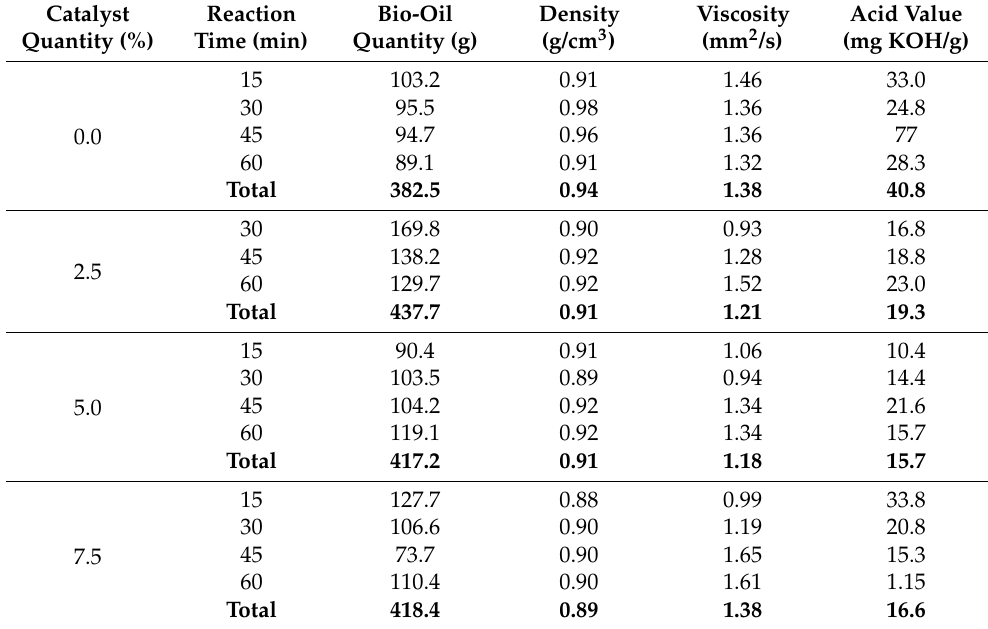
Table 7. Weighted average of determined physical–chemical properties and their respective measured properties of time fractions for catalytic upgrading